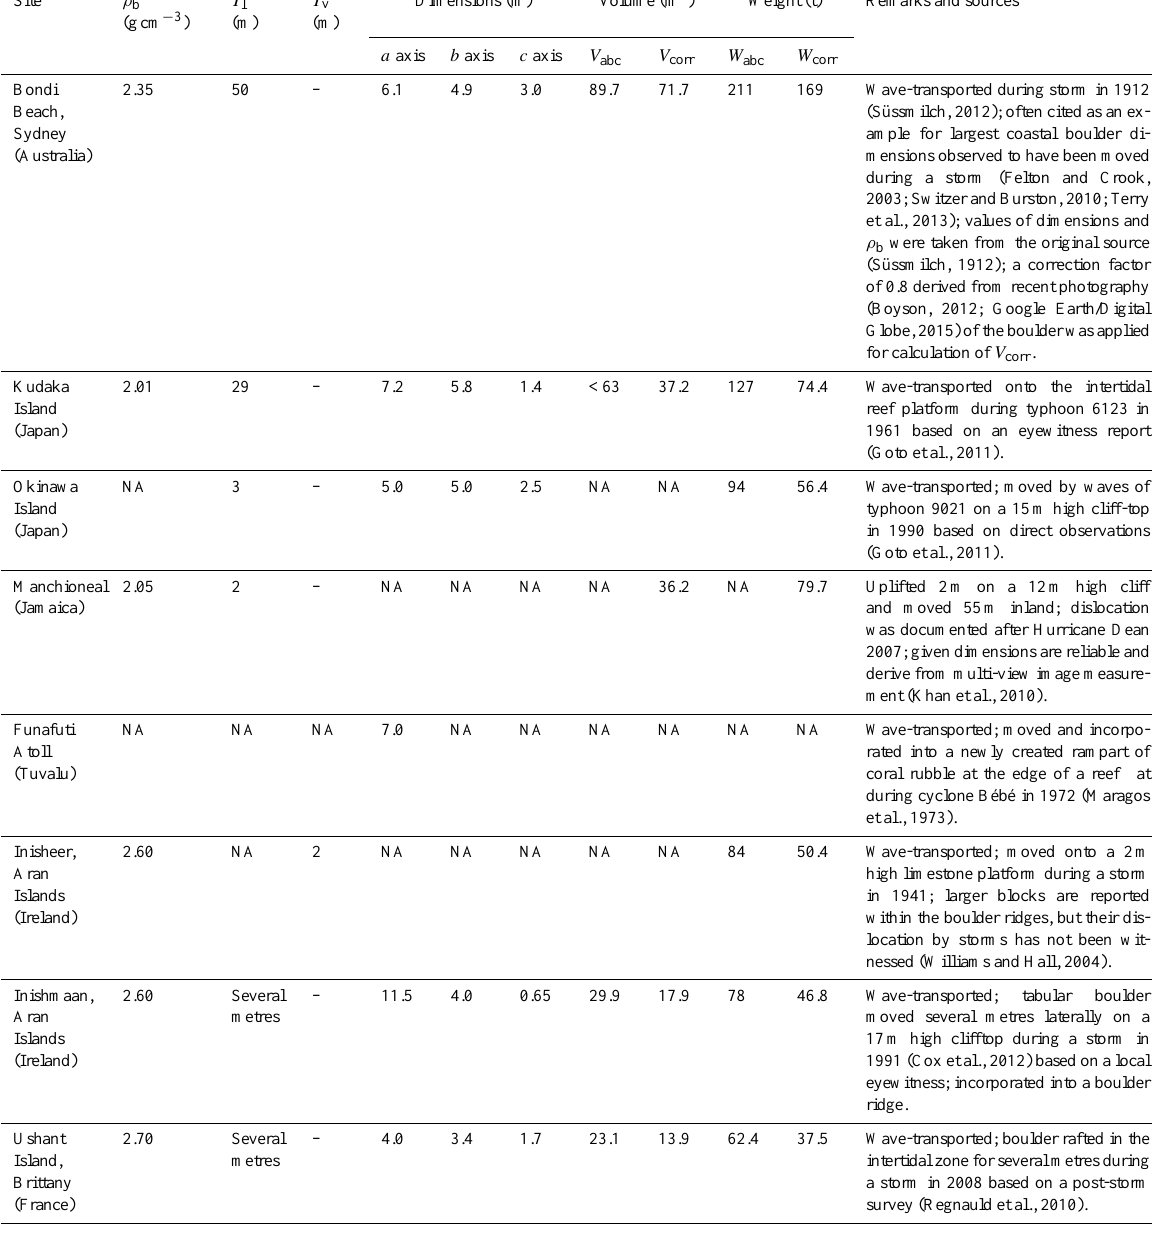
Table 1. Boulder axes, volume, and weight of very large storm-transported clasts from the literature documented by eyewitnesses or remote sensing. Uncorrected and tentatively corrected volumes ( V abc , V corr ) and weights ( W abc , W corr ) are given using a correction factor of 0.6 (0.8 for the rather cubic boulder at Bondi; Boyson, 2012; Google Earth/Digital Globe, 2015). T l : lateral transport; T v : vertical transport; ρ b : bulk density. The displacement of the above-indicated clasts occurred due to direct storm wave impact. For the block at Bondi Beach the original source gives a weight of “about 235t” (Süssmilch, 1912, p. 155), whereas multiplication of axes and local rock density of ca. 2.35gcm − 3 (Süssmilch, 1912; Verhoef, 1993) reveals only 211t. Furthermore, questions about the reliability of the report on the storm wave transport in 1912 have been raised, citing pre-1912 photographs of the boulder in its present position (Cass, 2002; Scheffers et al., 2008). T l T v Site ρ b Dimensions (m) Volume (m 3 ) Weight (t) Remarks and sources (gcm − 3 ) (m) (m)